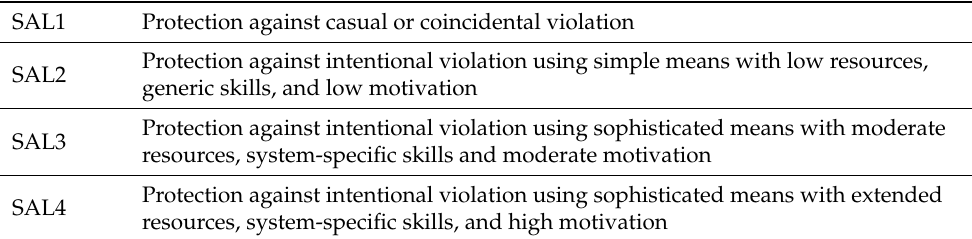
Table 3. Cybersecurity levels